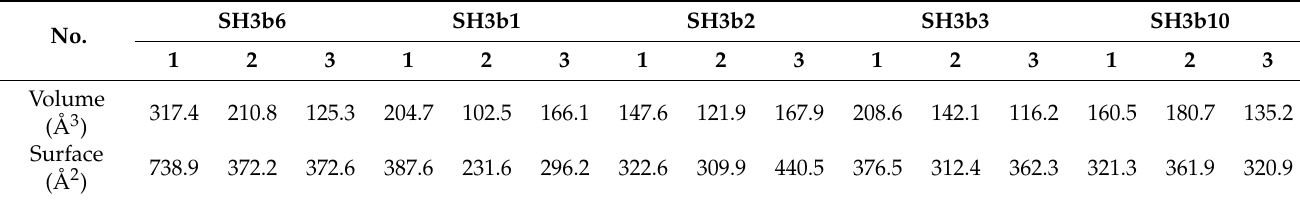
Figure 8. Potential ligand-binding pockets of CpAcp SH3b1/2/3/10. ( A ) Three pockets were identified for respective structure models of SH3b1/2/3/10 and are shown with mesh. The pockets are numbered according to those of SH3b6 and respectively colored with green, magenta, and orange. ( B ) Sequence alignment of SH3b1/2/3/6/10 with the residues involved in forming individual pockets colored in the same manner in ( A ). Secondary structural elements of SH3b6 are indicated above the amino acid sequence. Conserved pocket residues among the five SH3bs are marked with asterisks. Table 4. Comparison of pocket size of SH3b1/2/3/6/10 of